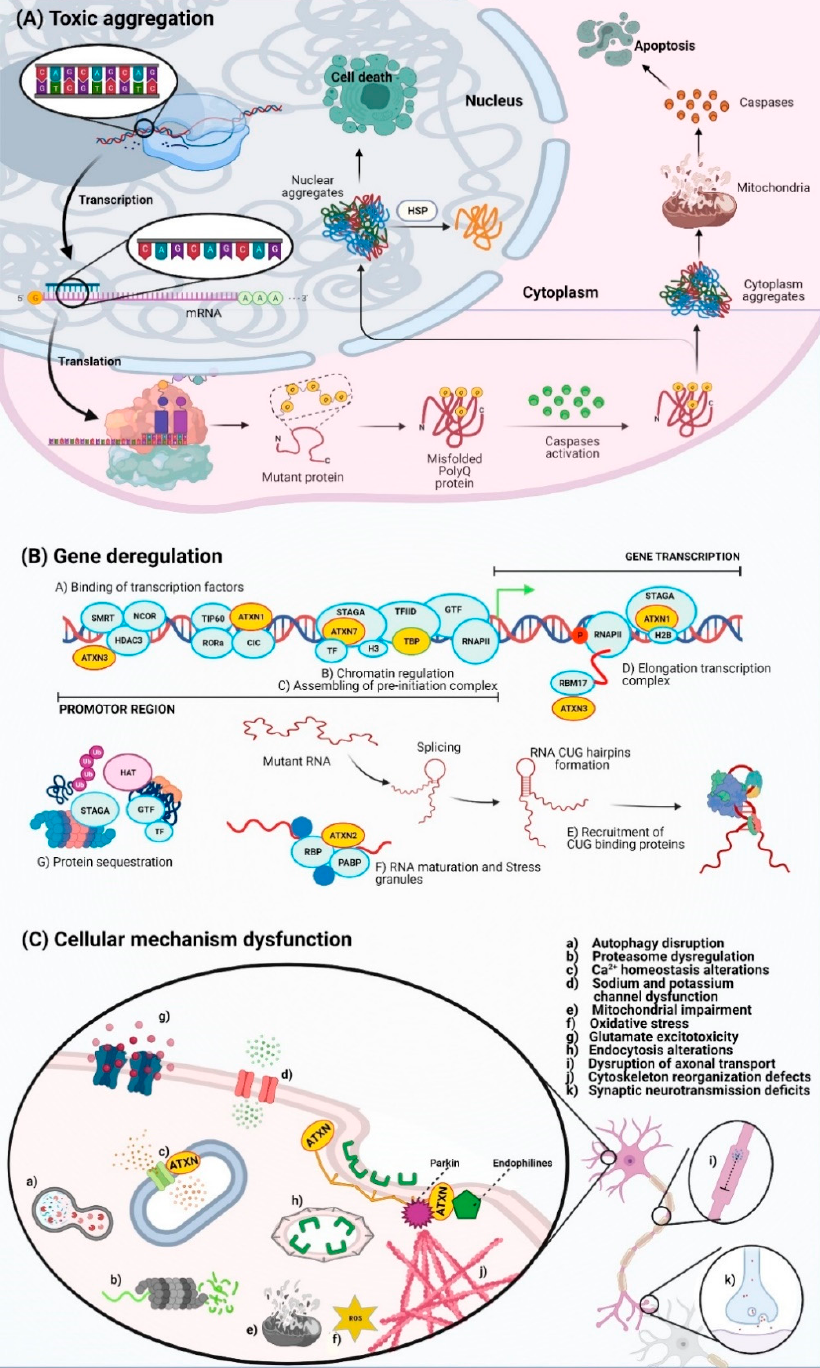
Figure 1. PolyQ protein aggregates disturb different cellular processes. ( A ) Intracellular fate and aberrant aggregation of polyQ proteins. ( B ) Role of mutant proteins and their corresponding RNA transcripts in gene expression. ( C ) Altered cellular pathways that trigger neurodegeneration in polyQ SCAs. See the text for